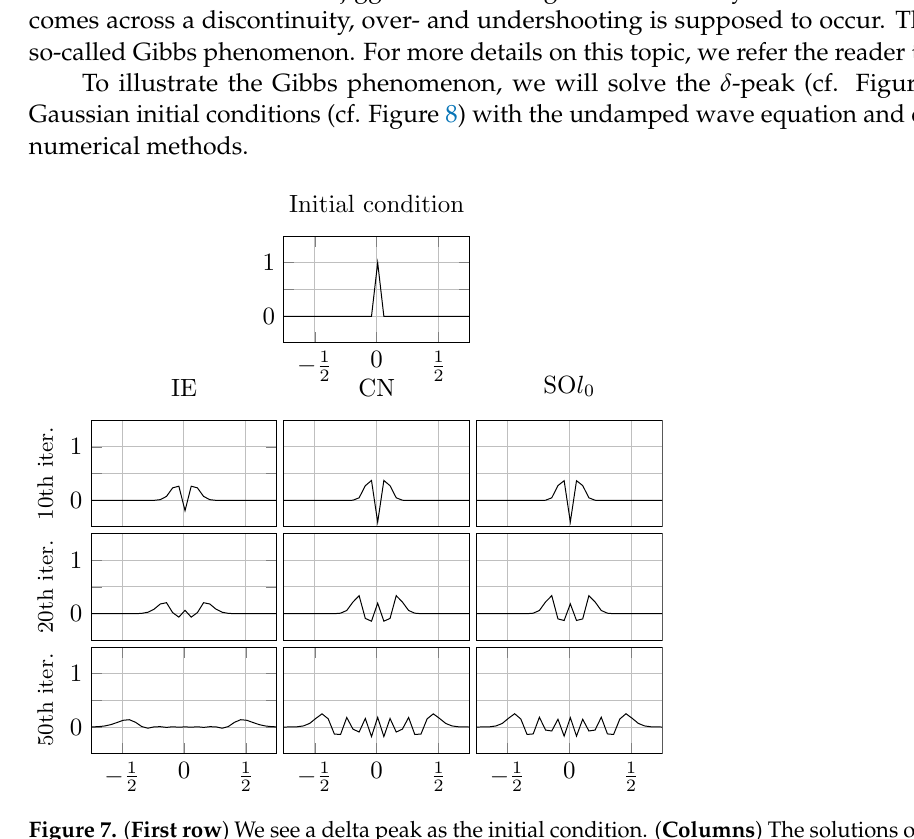
Figure 7. ( First row ) We see a delta peak as the initial condition. ( Columns ) The solutions of different numerical schemes (left to right) for the IE, CN and SO l 0 schemes are presented. ( Rows 2–4 ) We see the solution after different iterations. In the second row, we calculated 10 iterations. The third row shows us the solution after 20 iterations, and in the fourth row, the 50th iteration is presented. All numerical schemes show these oscillations, called the Gibbs phenomenon. This is more visible in the second-order schemes than in the first-order method. The time increment was set to τ =